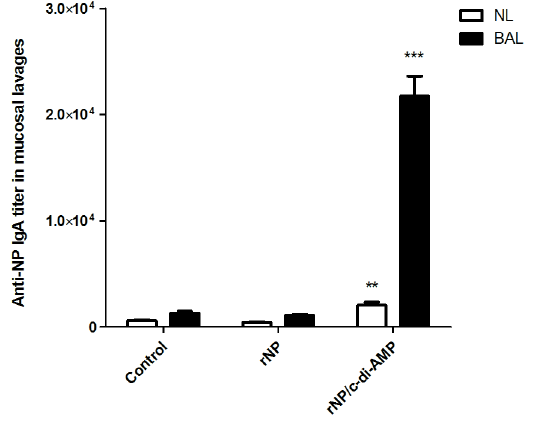
Figure 2. Evaluation of NP specific IgA in mucosal lavages. NP- specific IgA titers measured by ELISA in nasal (NL) and BAL lavages of BALB/c mice immunized with two doses of rNP (10 m g/dose) alone or co-administered with c-di-AMP (10 m g/dose) by intranasal route at an interval of 3 weeks. Control animals received PBS. Results are expressed as NP specific IgA titer. The S.E.M. is indicated by vertical lines. Differences were statistically significant at p , 0.001 (***) and p , 0.01 (**), compared with the titers in mice immunized with rNP